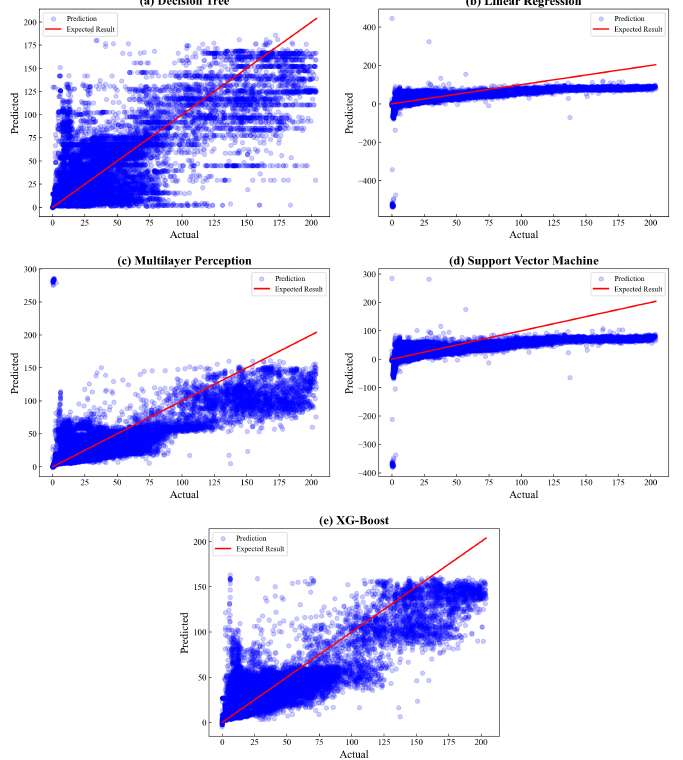
Figure 16. Actual vs. predicted plot of CO